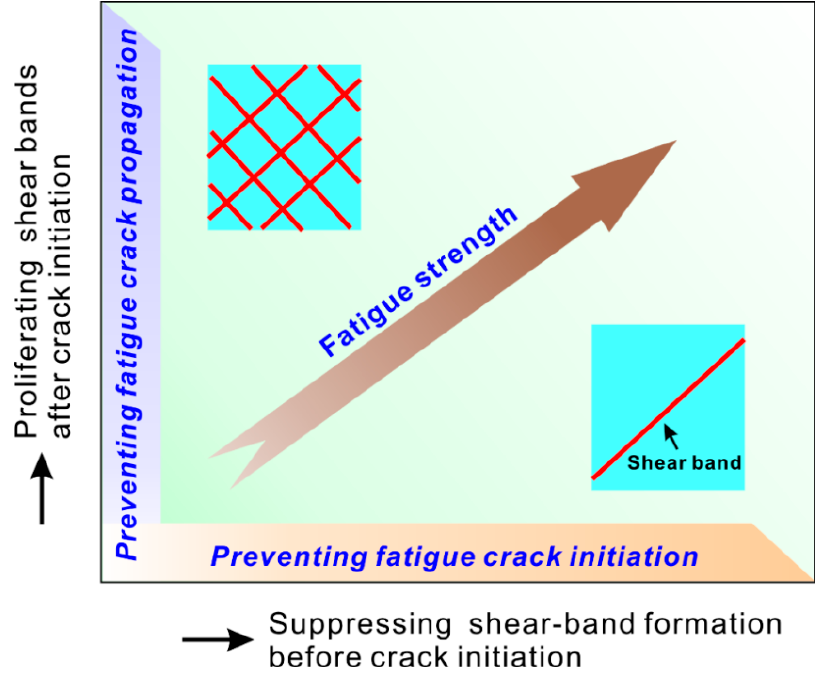
Figure 11. Two approaches to improve the fatigue strength of MGs: (1) preventing fatigue crack initi- ation via suppressing shear-band formation; (2) preventing fatigue crack propagation via promoting shear-band proliferation during fatigue crack propagation